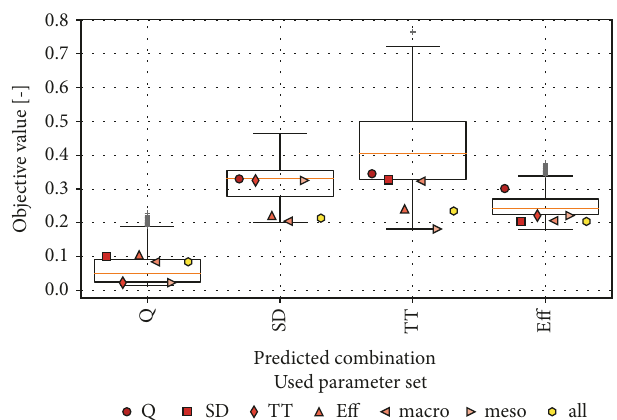
Figure 10: The distribution of the objective values per metric combination is displayed by the boxplots. The markers indicate, per used parameter set, how much the objective value would deviate from its optimum if the optimal parameter set, obtained using another (combination of) metrics(s), would be used. The combinations are identified by their acronyms as found in Table